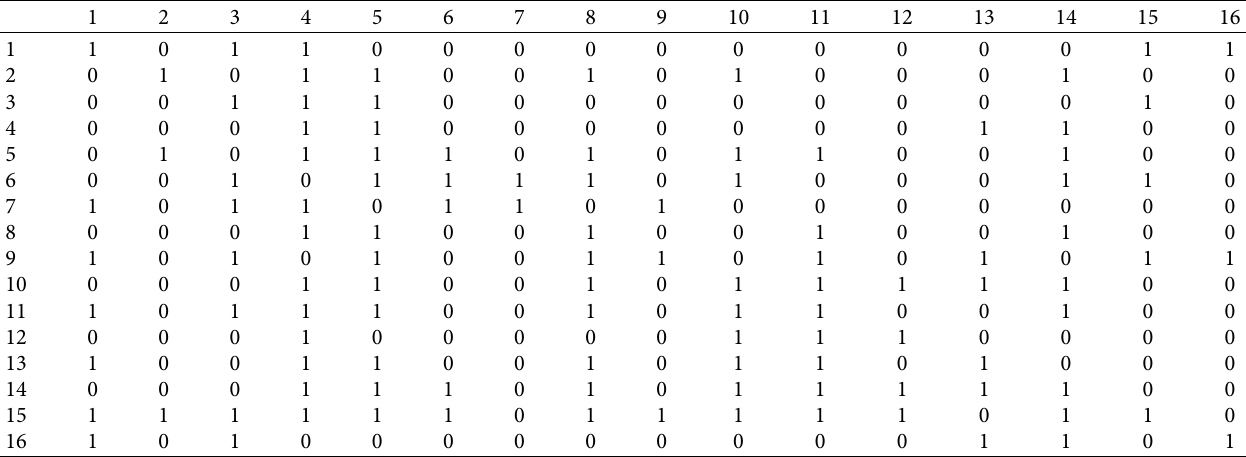
Table 3: Reach-ability matrix after transitivity.